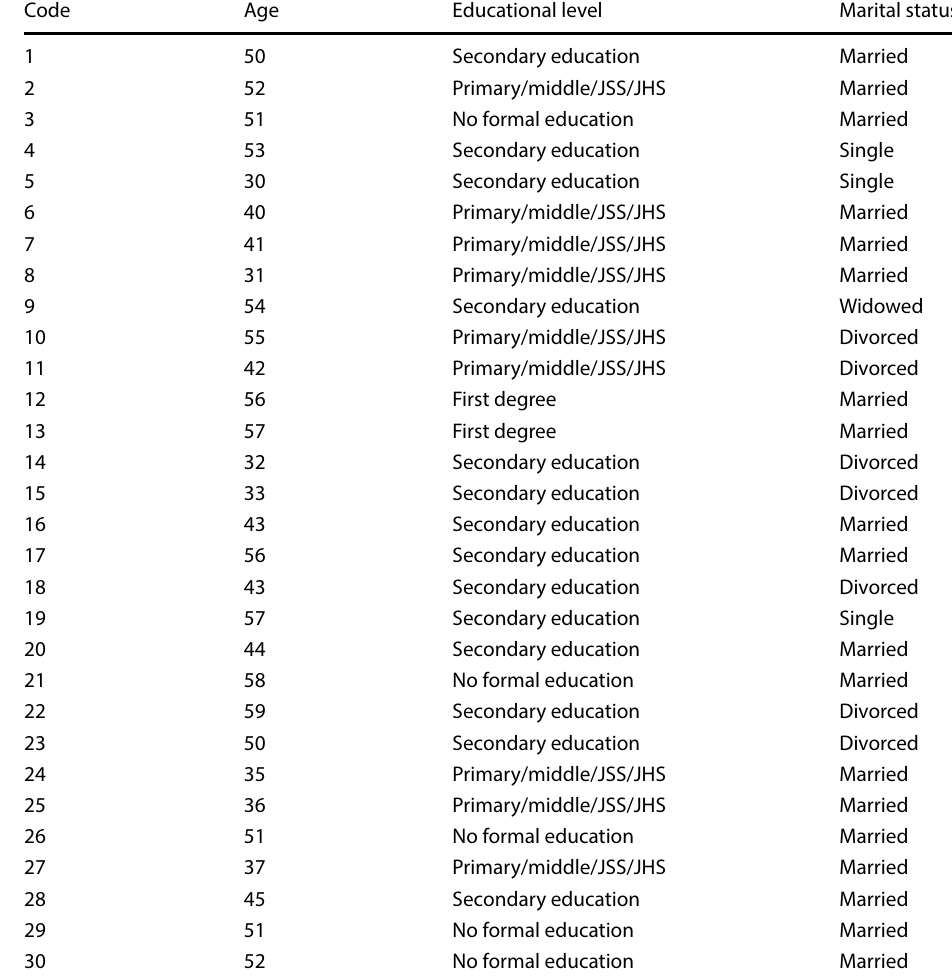
Table 1 Demographic characteristics of one-on-one interview